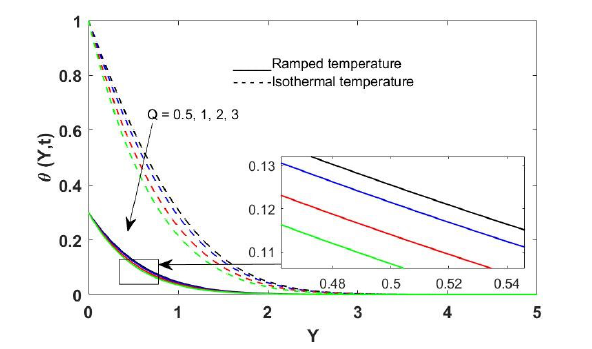
Figure 10: Momentum distribution versus R t =0.3, E=1, S=1, Q=0.2, K=1, kp=1.5, Ω = 30 0 , ψ = 0.5 , Pr =0.71, Sc =0.60, Gr=3, Gc=4